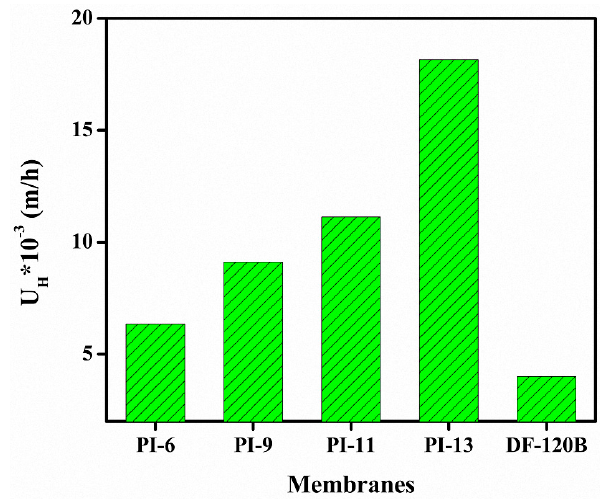
Figure 7. Dialysis coefficient (U H ) of HCl at 25 °C of BPPO-based AEMs with increasing amounts of PI membranes.